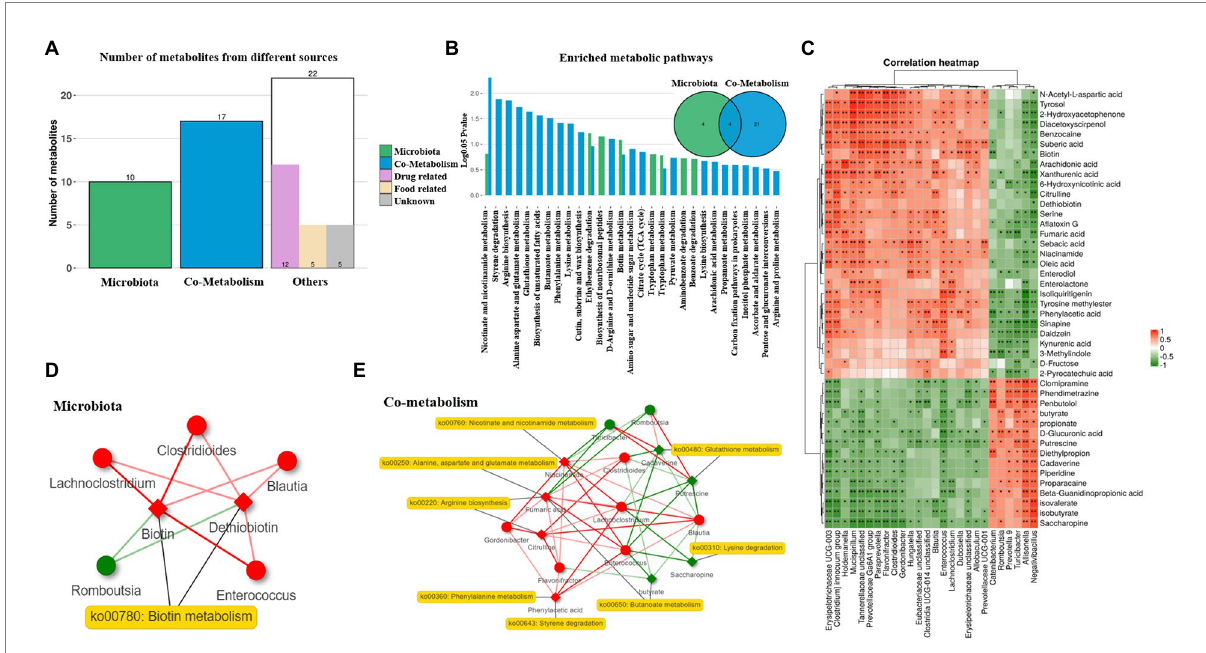
FIGURE 5 MetOrigin analysis on the differential fecal microbiota and metabolites between the CON and DBP groups. Bar plot of the number of metabolites in different categories (A) . Venn diagram and bar plot of the number of enriched metabolic pathways from origin-based MPEA analysis (B) . Correlation analysis between the differential fecal microbiota and metabolites using Spearman (C) . Network summary of DBP on beagle dogs for microbiota (D) , and co-metabolism (E) . Diamond and dot shapes indicate correlate metabolites and bacteria, correspondingly. The red/green color of nodes indicates up/down regulation. The red/green lines indicate the positive/negative correlations between microbes and metabolites. The symbol (*) indicates a significant correlation (* p < 0.05 and ** p <